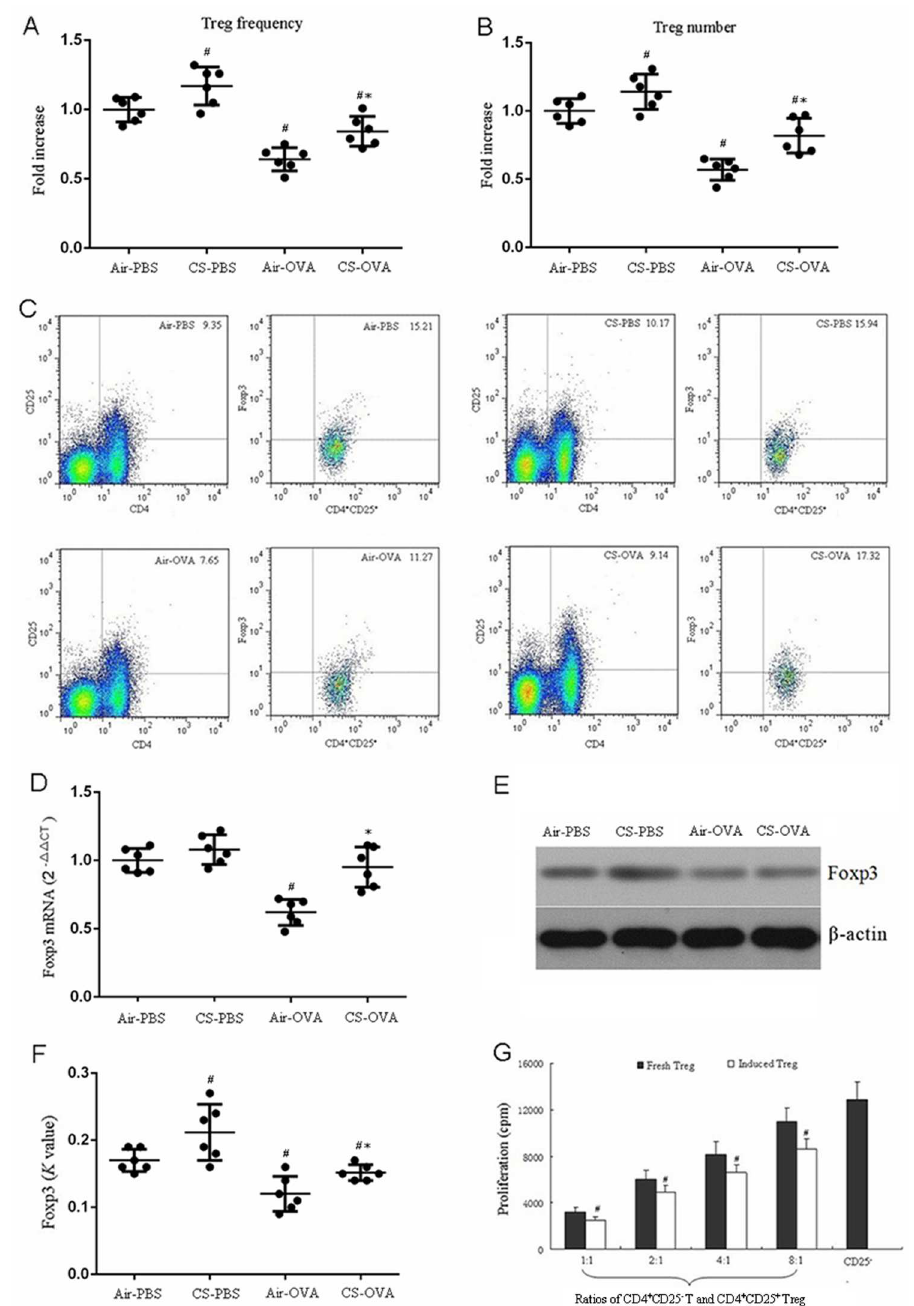
Fig 3. Early-life CS exposure induced Treg-mediated immune suppressive activity. (A-C) The population of CD4 + CD25 + Tregs of lung tissue was analyzedby flow cytometry. The Treg frequency (A) and number(B) were determinedfrom the data shown in (C). Foxp3 expressionof lung tissue was estimated by RT-PCR (D) and western blotting(E-F). The proliferation of lung T cells at different ratios of CD4 + CD25 - to CD4 + CD25 + were assayed by the [ 3 H]-thymidineincorporation method. The fresh Tregs and the induced Tregs were isolatedfrom the lung of untreatedmice and CS-PBS mice, respectively.(G) The values are the means ± SD of the results from 6 mice per group. # P < 0.05vs. Air-PBS group; * P < 0.05vs. Air-OVA group in (A, B, D and F). # P < 0.05vs. Fresh Tregs in (G).